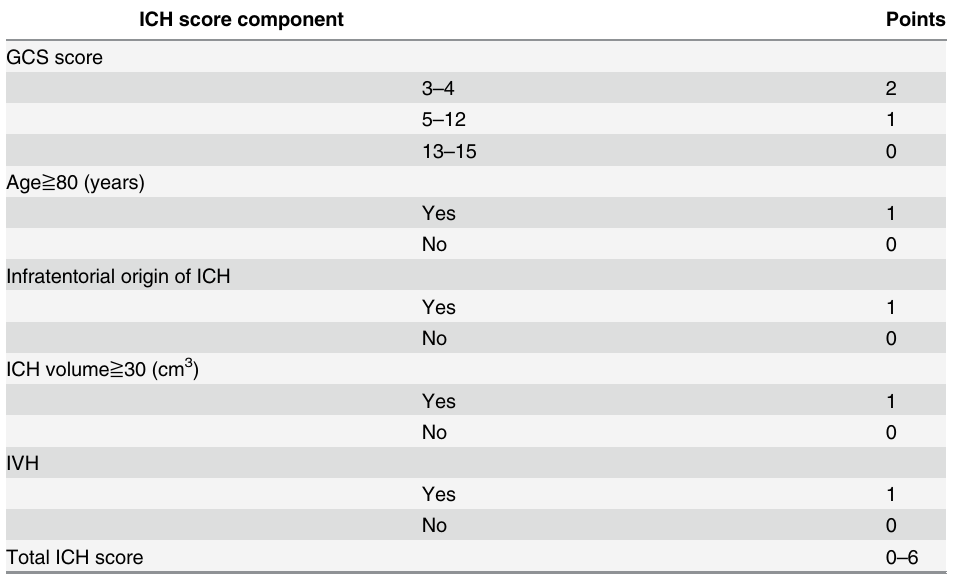
Table 1. Evaluation of fi ve components in ICH score